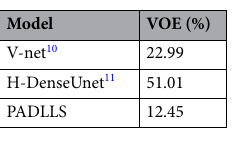
Table 3. Comparison of Volumetric Overlap Errors (VOE) for the case in Fig.